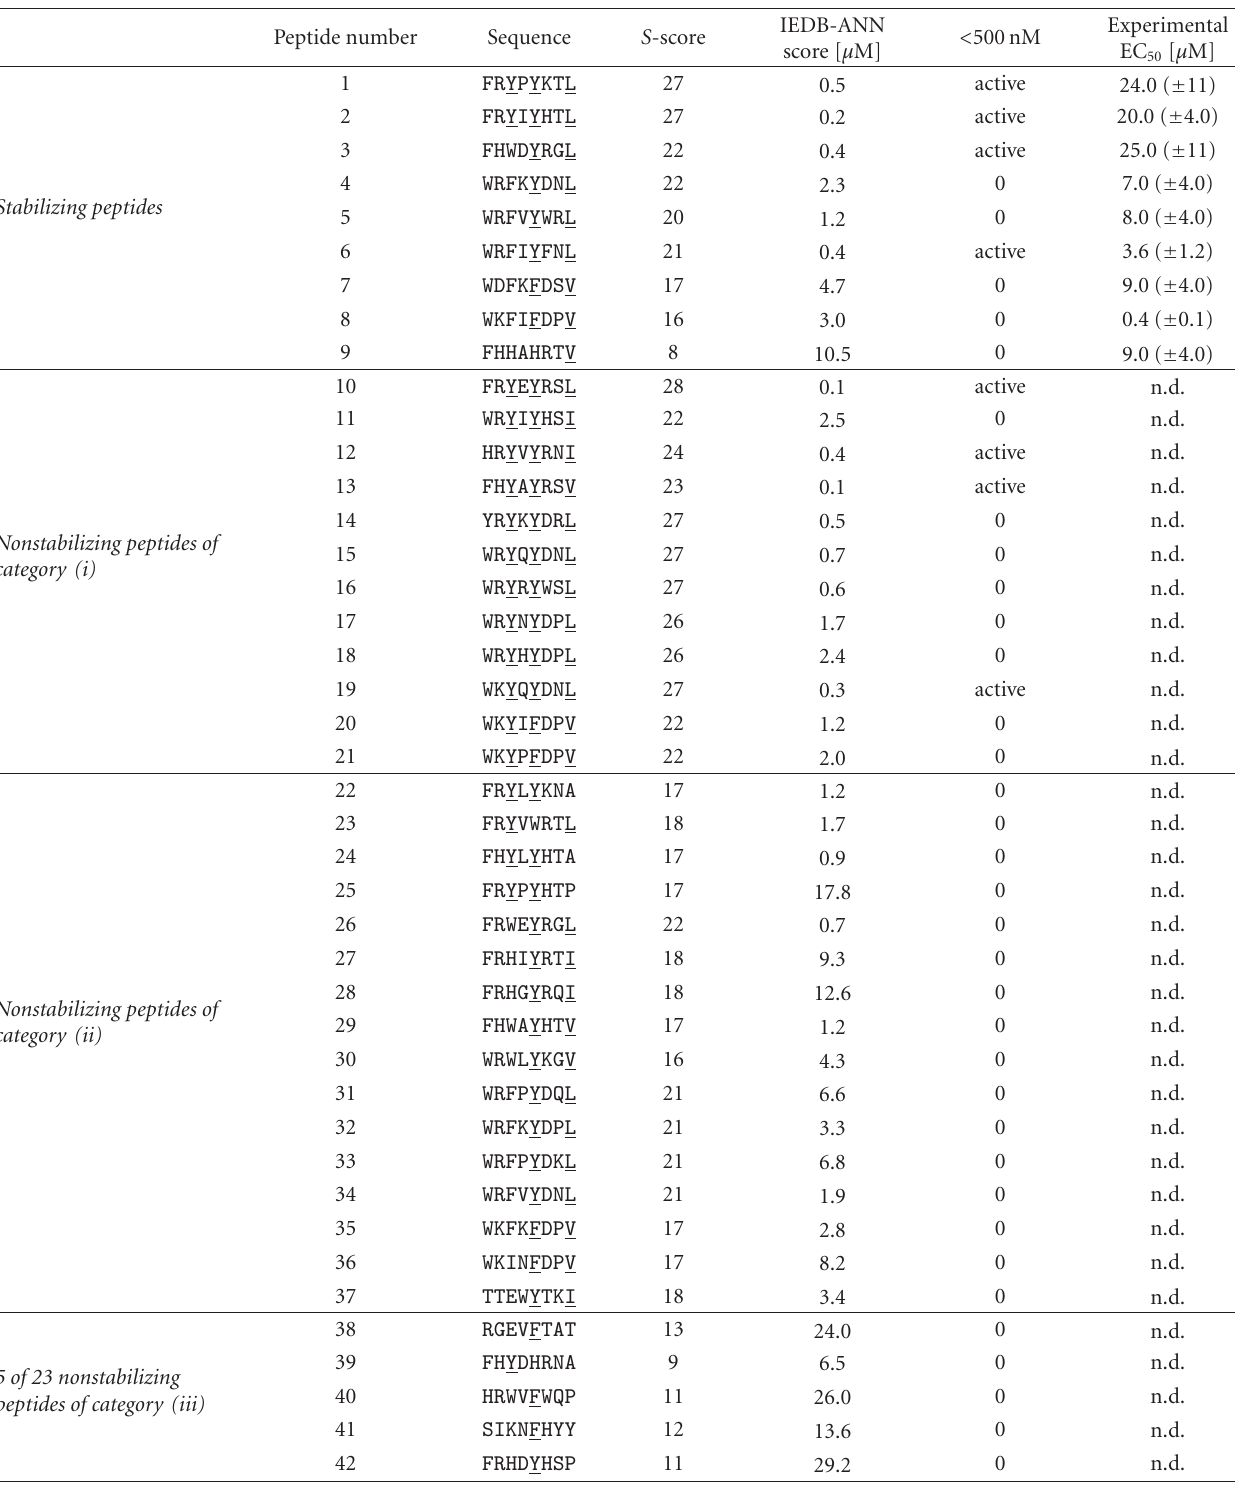
Table 1: Experimentally tested octapeptides. Sequences are given in single-letter code; motif anchor positions fulfilling the SYFPEITHI motif are underlined. S- score: SYFPEITHI score [6]. IEDB-ANN score: predicted IC 50 values by IEDB-ANN method [25]. < 500nM: recommended cuto ff for IEDB-ANN score [25] for binders predicted with intermediate a ffi nity; active : IEDB-ANN score < 500 nM; 0: IEDB-ANN score > 500nM. EC 50 values correspond to the peptide concentration required for 50% of maximal MHC I protein stabilization; values in brackets are standard deviations ( N = 3). n.d.: not